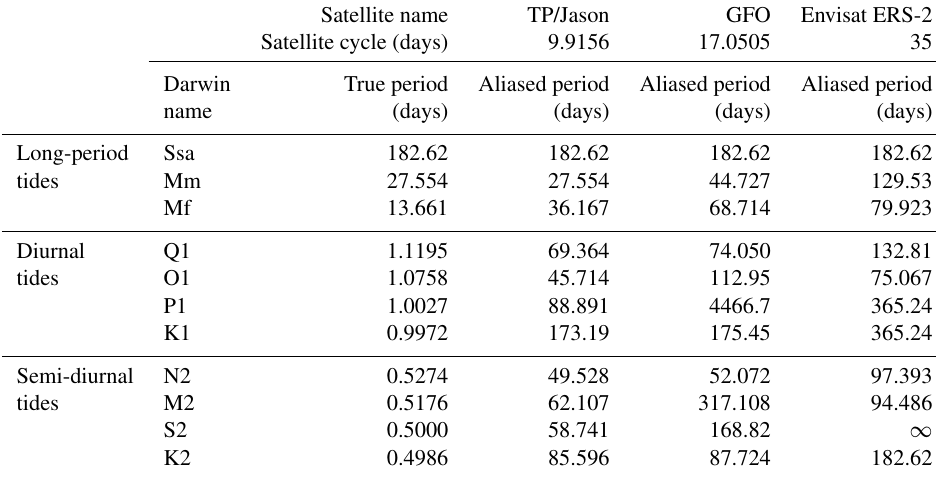
Table 2. Aliasing periods of main tidal waves for TOPEX/Jason, ERS/EN, and GFO altimeter samplings.